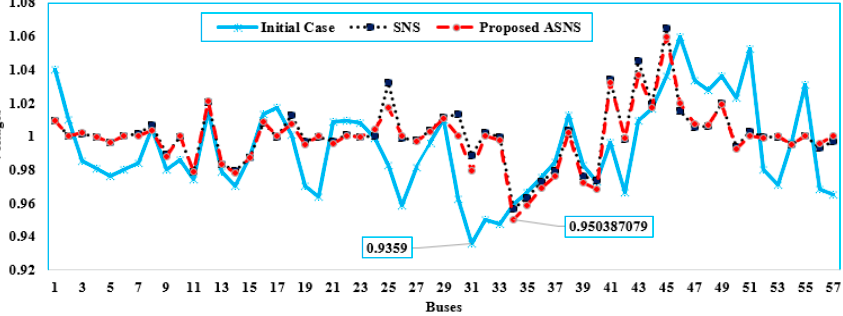
Figure 10. Voltage Profile of the proposed ASNS and SNS for Case 2 of the IEEE 57-bus grid.